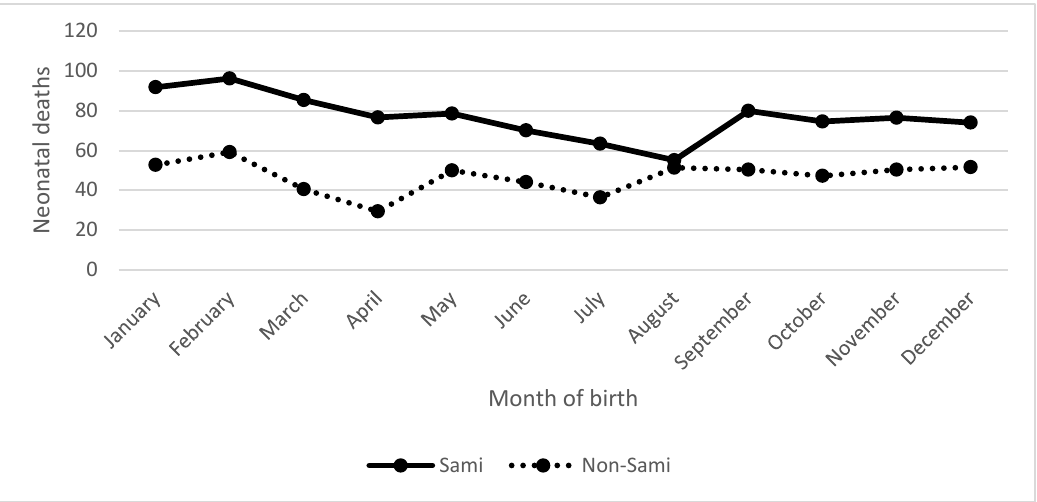
Figure 3. Neonatal mortality (q0–1) in North Sápmi by month of birth, 1800–1899. Source: Demographic Data Base, Umeå University.